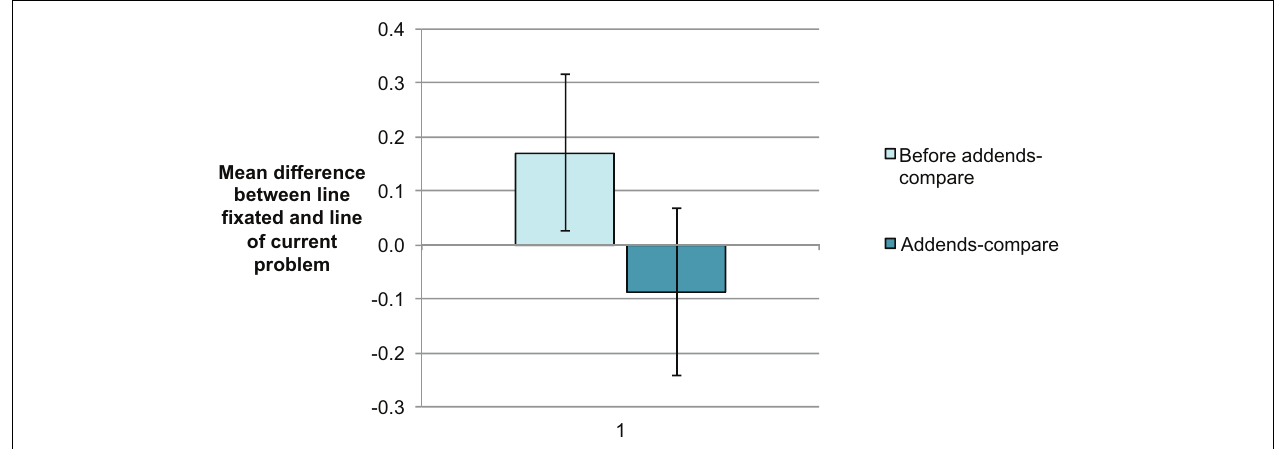
FIGURE 3 | Meandifferencebetweencurrentlinefixatedandlineofcurrentproblem. Negativevaluesindicatefixationsonprecedingproblemswhilepositive values result from fixations on subsequent problems. Error bars indicate the 95% CI of the comparison of addends-compare problems vs. preceding problems.